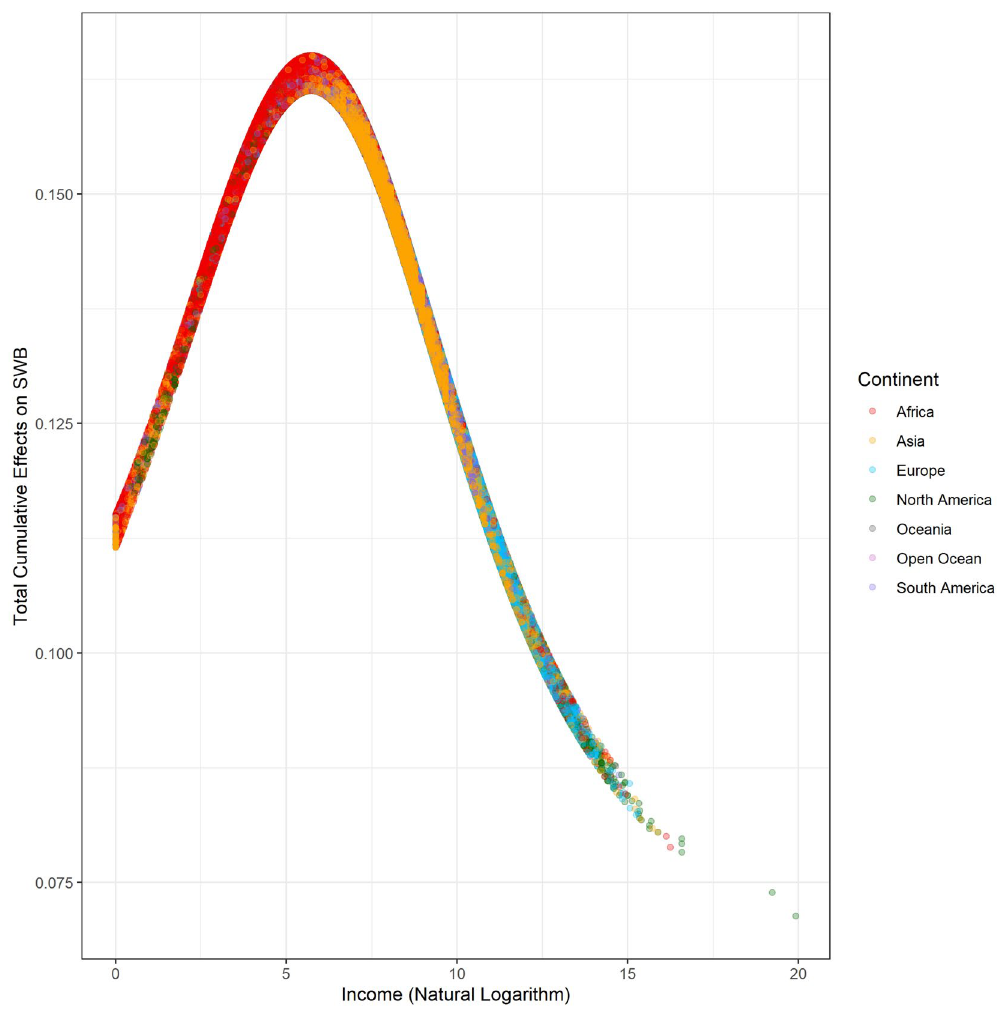
Figure 9. Distribution between the total cumulative effects of income on SWB and income by continent.